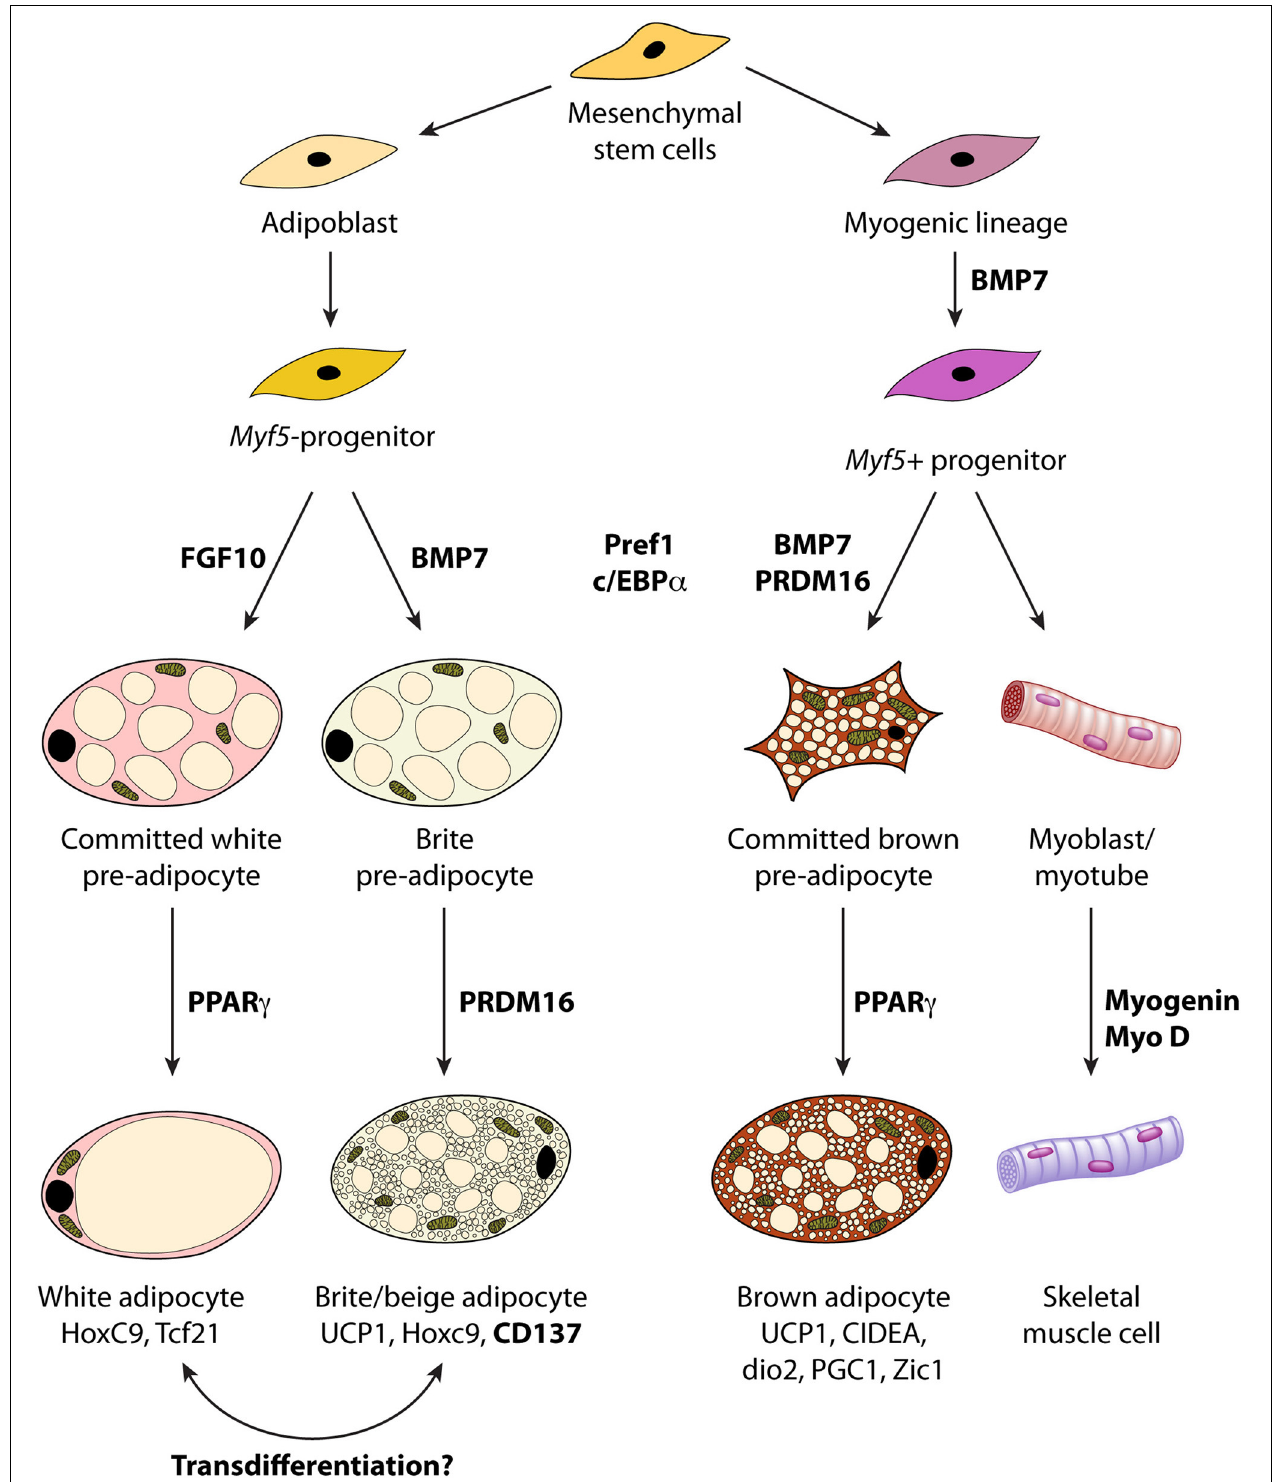
FIGURE 1 | Lineage of white, brown and “brite/beige” adipocytes from stem cells and molecular markers involved in the developmental program. BMP, bone morphogenetic protein; UCP1 uncoupling protein 1; PGC1, Peroxisome proliferator-activated receptor gamma coactivator 1.